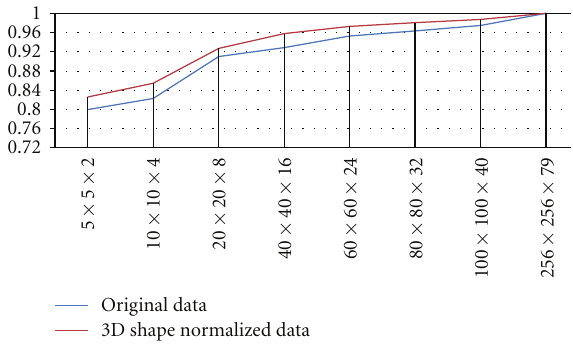
Figure 8: Normalized correlations while basis increasing.